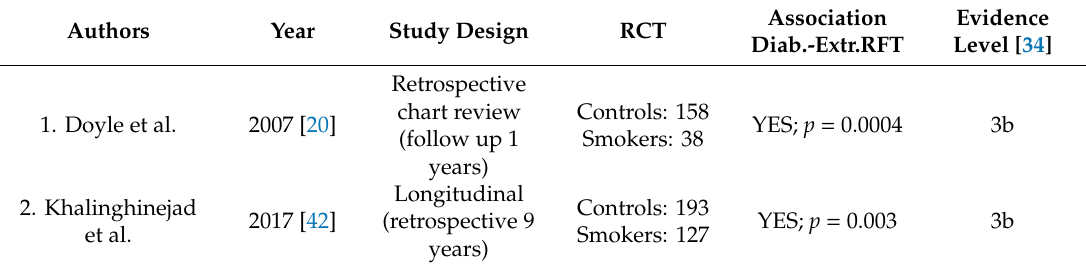
Table 2. Studies about smoking habits and the prevalence of root filled teeth extraction included in the systematic review. Study design, subjects and sample size, main results, and evidence level